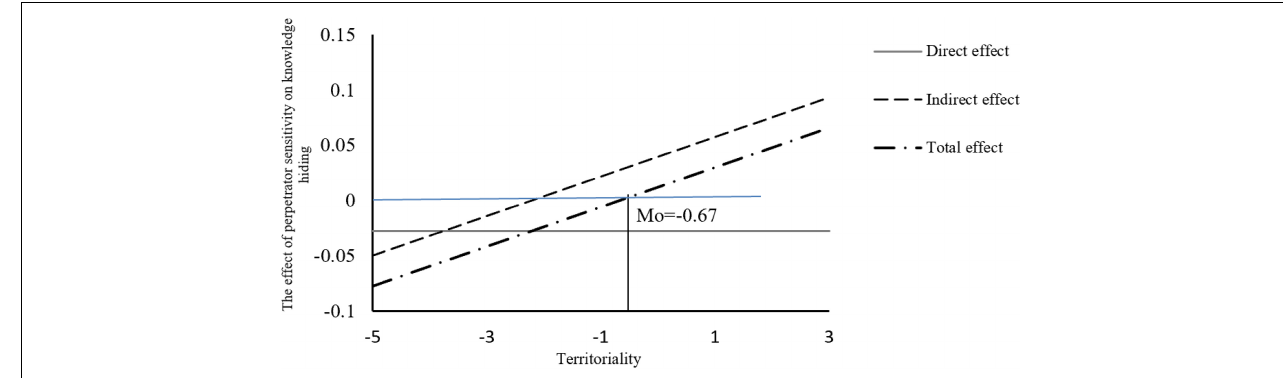
FIGURE 5 | Slope diagram of the mediating effect of perpetrator